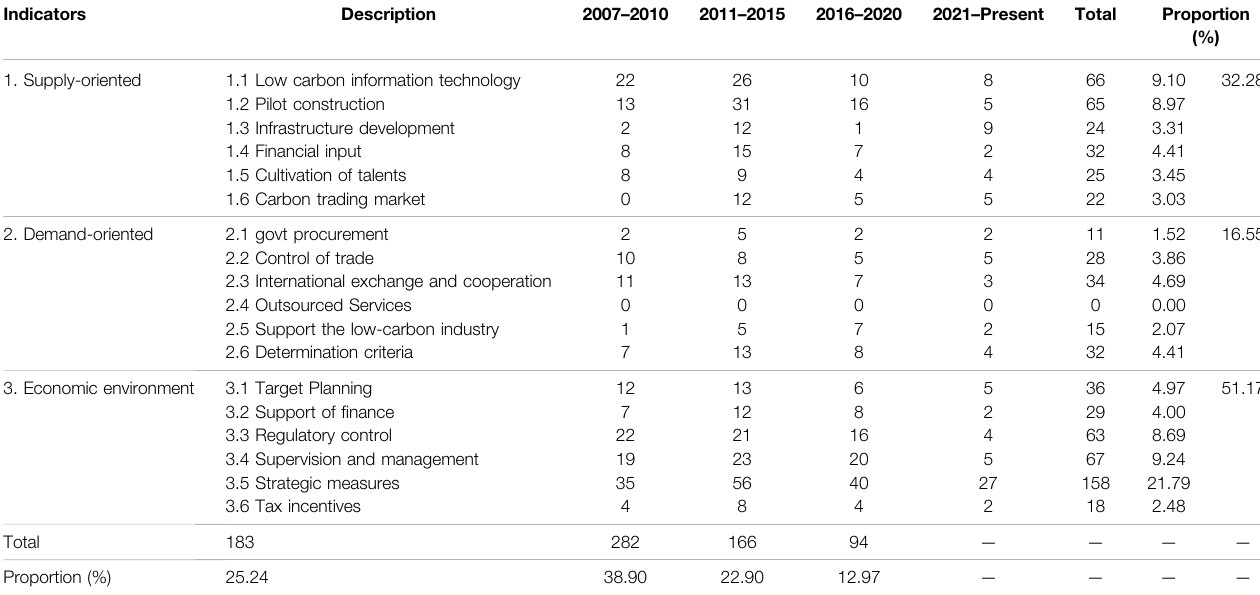
TABLE 3 | Two-dimensional distribution table of Dimension one and Dimension two matrices. Indicators